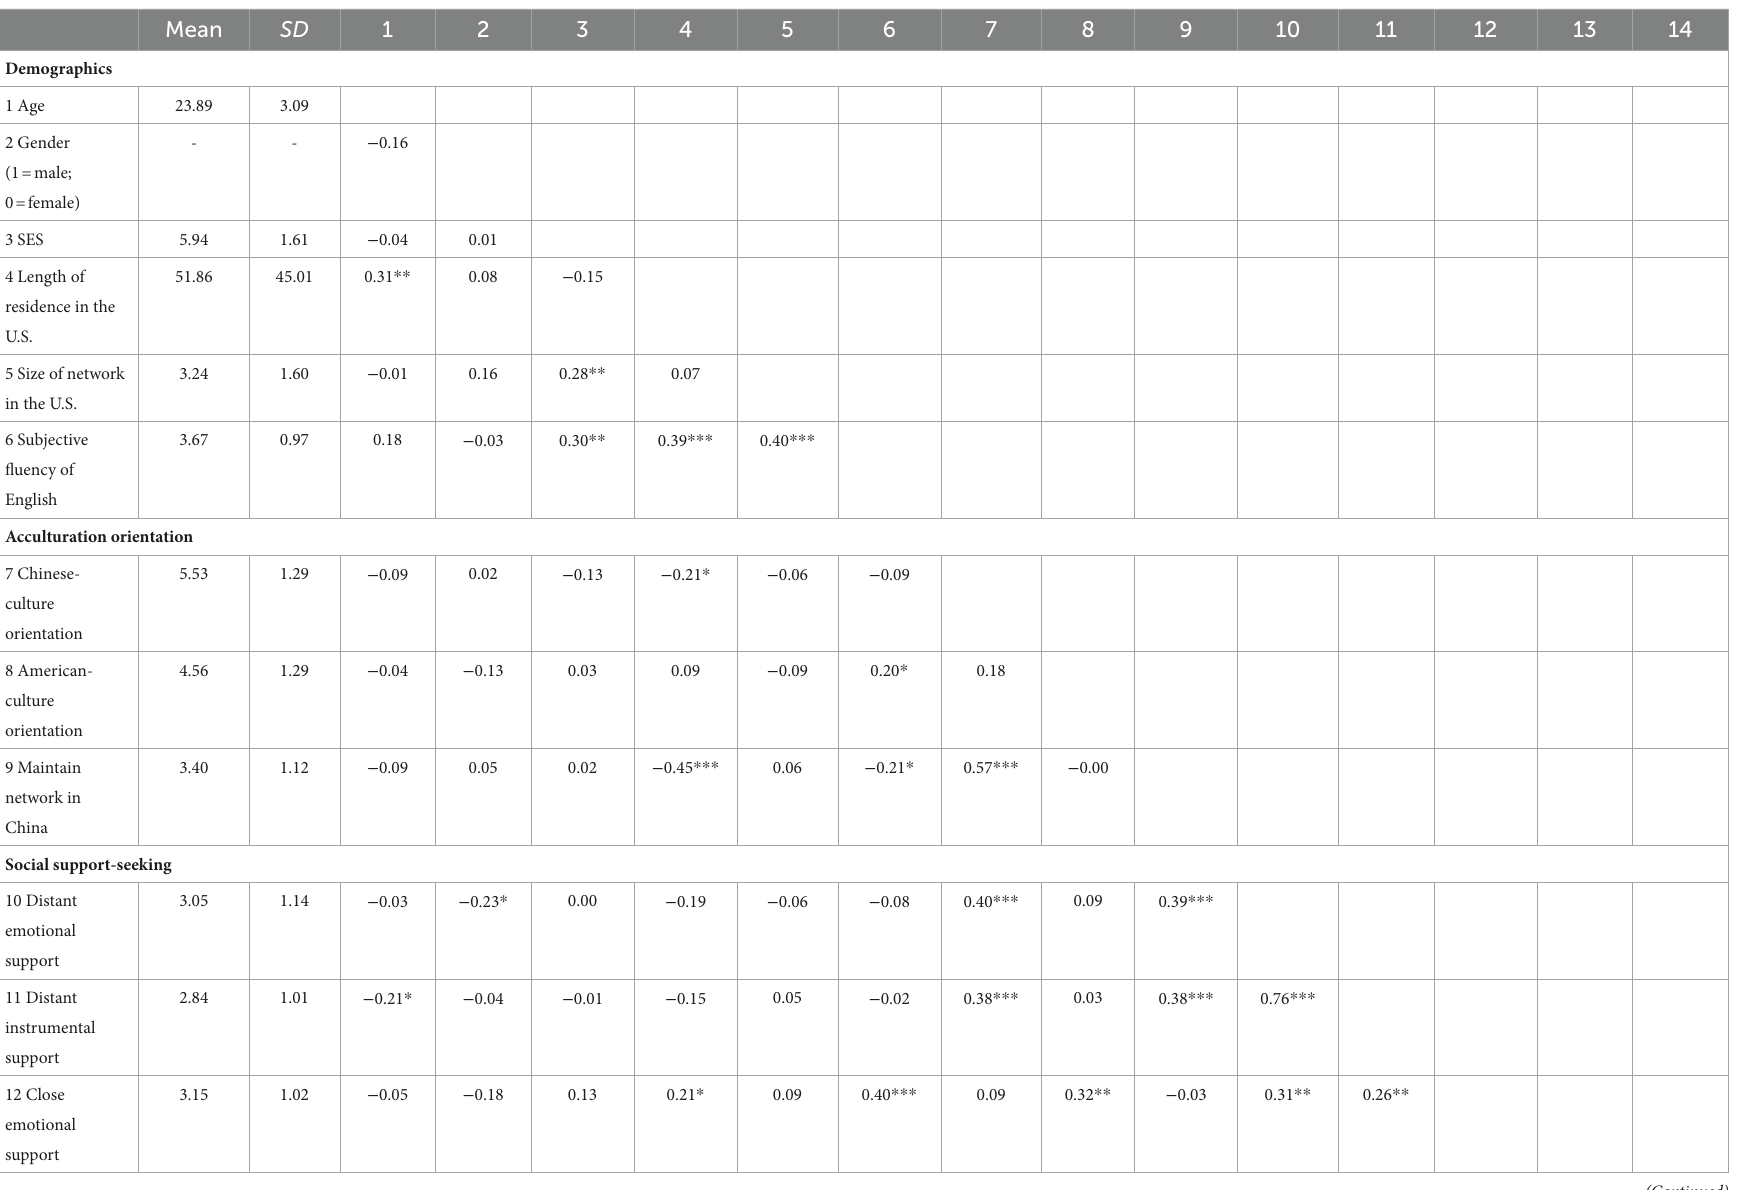
TABLE 3 Means, standard deviations, and Pearson’s correlations of all variables in Study